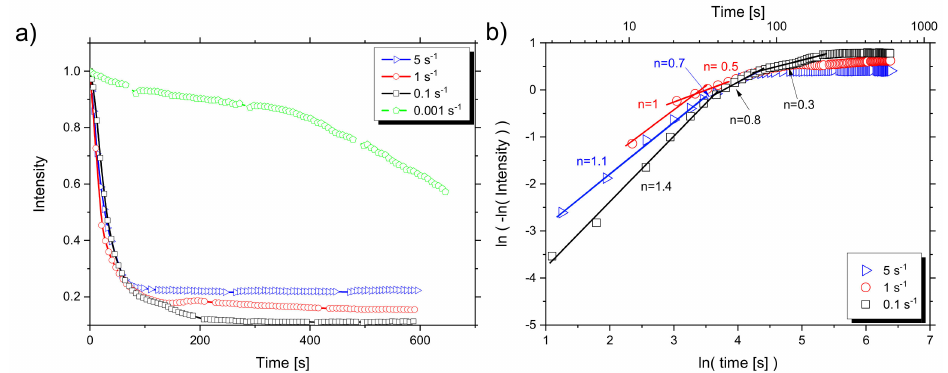
Figure A2. Normalized intensity evolution as a function of time during heat treatment after compression for the β -110 plane. ( b ) A double logarithmic scale of ( a ) after Equation (3). Straight lines indicate the linear fit and besides corresponding slopes ( n -exponent) are